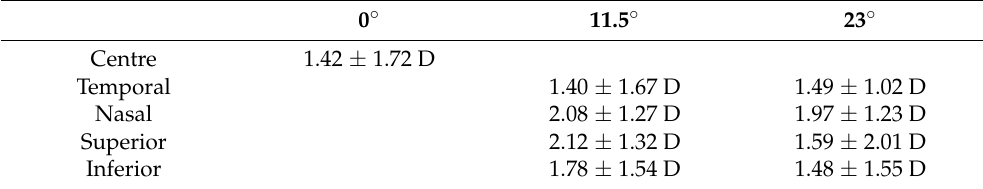
Table 1. Average changes in accommodation on different central and peripheral